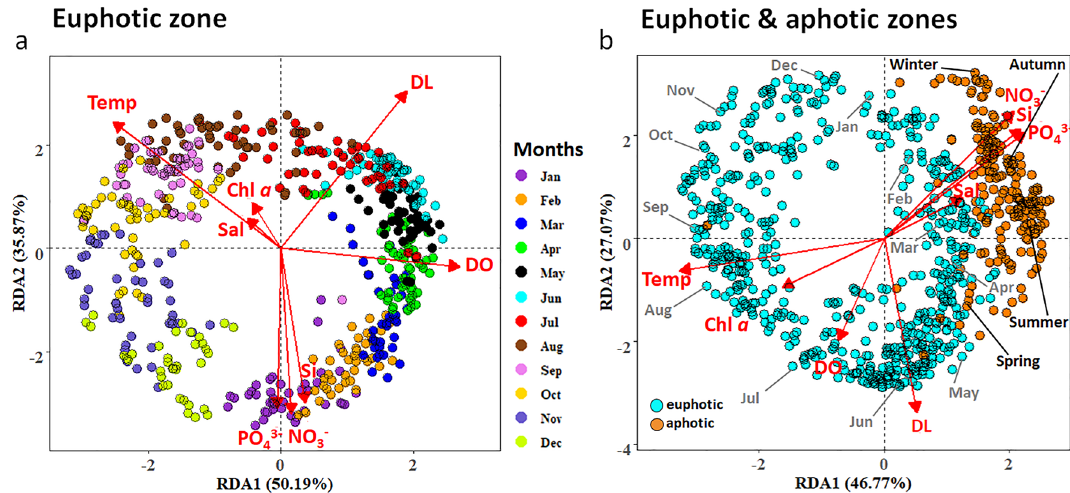
Figure 4. Redundancy analyses (RDA) to characterize the specific abiotic variables in the water column which exerted the largest influence on the prokaryotic community composition in euphotic zone only ( a ) and across all four depths ( b ). The ASV data were CLR transformed and environmental parameters were standardized with the ‘standardize’ function using decostand from the Vegan Package 45 . Months are coded with different colours ( a ) and sampling depths are colour coded in cyan (euphotic zone; 1, 5, 10 m) and orange (aphotic zone; 60 m; b ). Abbreviated months are shown in grey, and seasons are highlighted in black for the aphotic zone ( b ). Vector abbreviations are temperature (temp), salinity (sal), chl a (chlorophyll- a ), dissolved oxygen (DO), day length (DL), nitrate (NO 3 − ), silicate (Si), phosphate (PO 4 3−